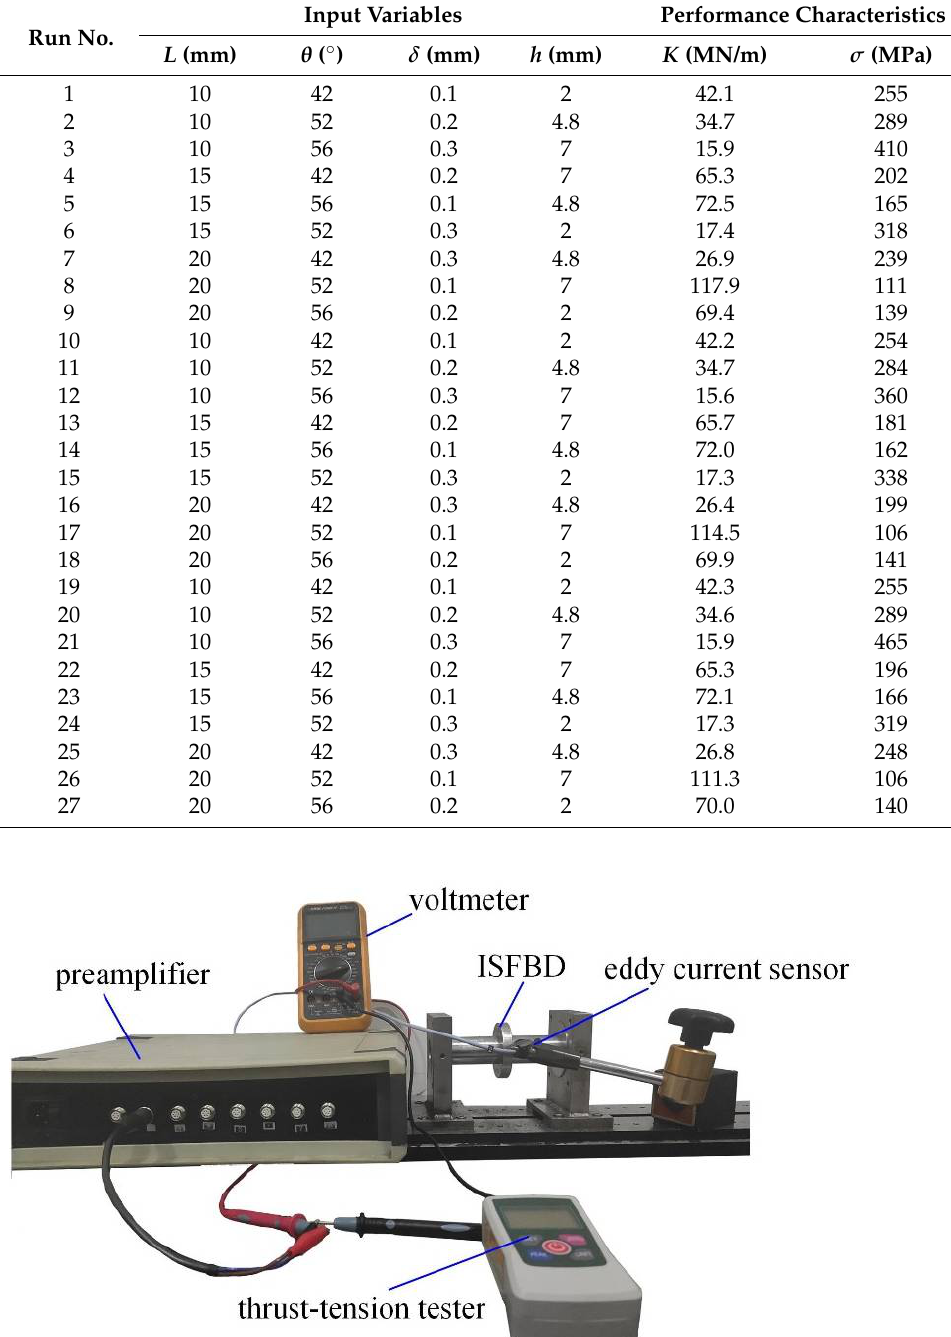
Figure 9. Force-displacement diagram. 4.3. Weight Analysis of Stiffness and Stress Combining Table 1 and Figure 10 shows that the stiffness increases as the axial length increases from 10 to 20 mm, with the maximum value of stiffness obtained at 20 mm. Sim- ilarly, the stiffness increases as the radial height increases and the film gap decreases. The distribution angle is found to have almost no significant effect on the stiffness.